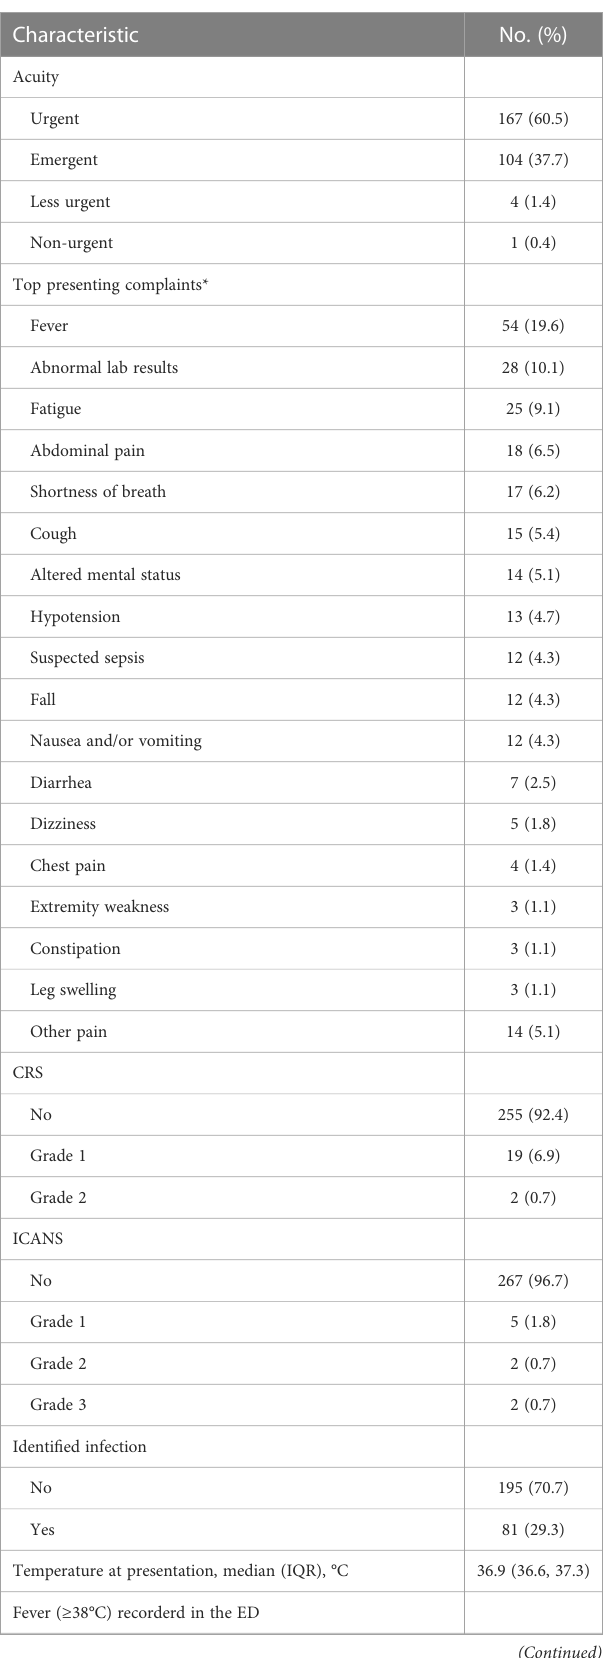
TABLE 2 Characteristics of emergency department visits by cancer patients in our analysis who had initiated chimeric antigen receptor T-cell infusion therapy within the past 6 months (total number of visits =